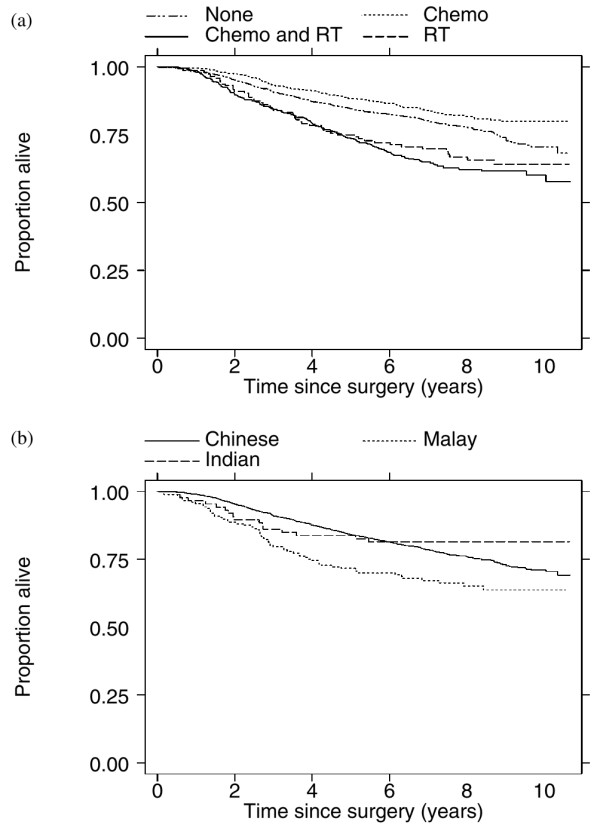
Kaplan-Meier survival estimates. (a) Patients undergoing mastectomy alone and those receiving adjuvant chemotherapy or radiotherapy, or both. (b) By ethnic group. Chemo, chemotherapy; RT, radiotherapy.